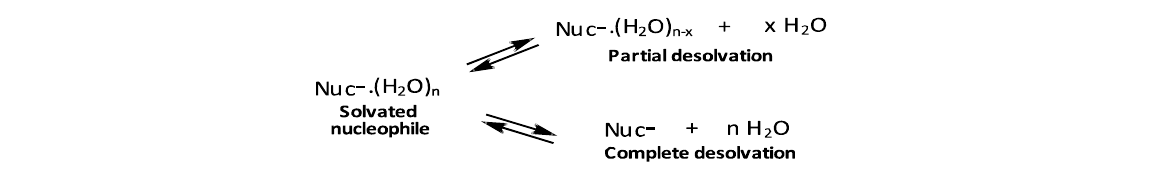
FIGURE 8 Desolvation of a solvated nucleophile molecule in the GS, giving rise to a more reactive nucleophile; the desolvation may be partial or